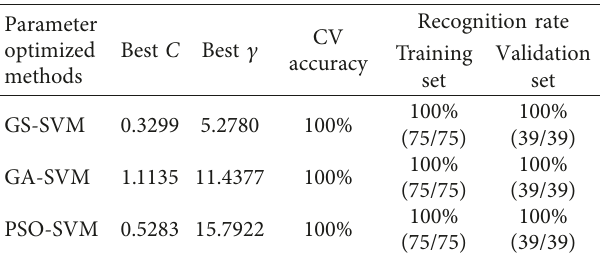
Table 5: Optimization parameters and predicting results of SVM models based on three parameter optimization algorithms.